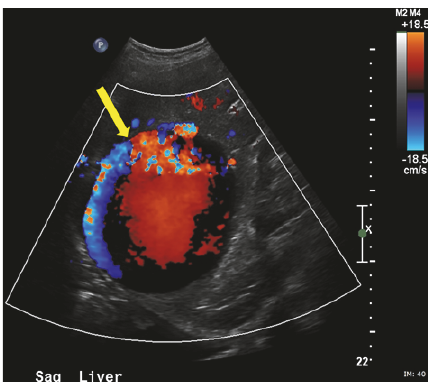
Figure 3: Anterior projection digital subtraction angiography demonstrating selective cannulation of right hepatic artery (red arrow). Multiple embolization coils (Tornado 0.08 embolization microcoils and interlocking 2D helical 8 × 20 coils) are filling the right hepatic artery lumen (blue arrow). Few displaced coils and mild residual contrast blush is noted within the aneurysm sac (yellow arrow).